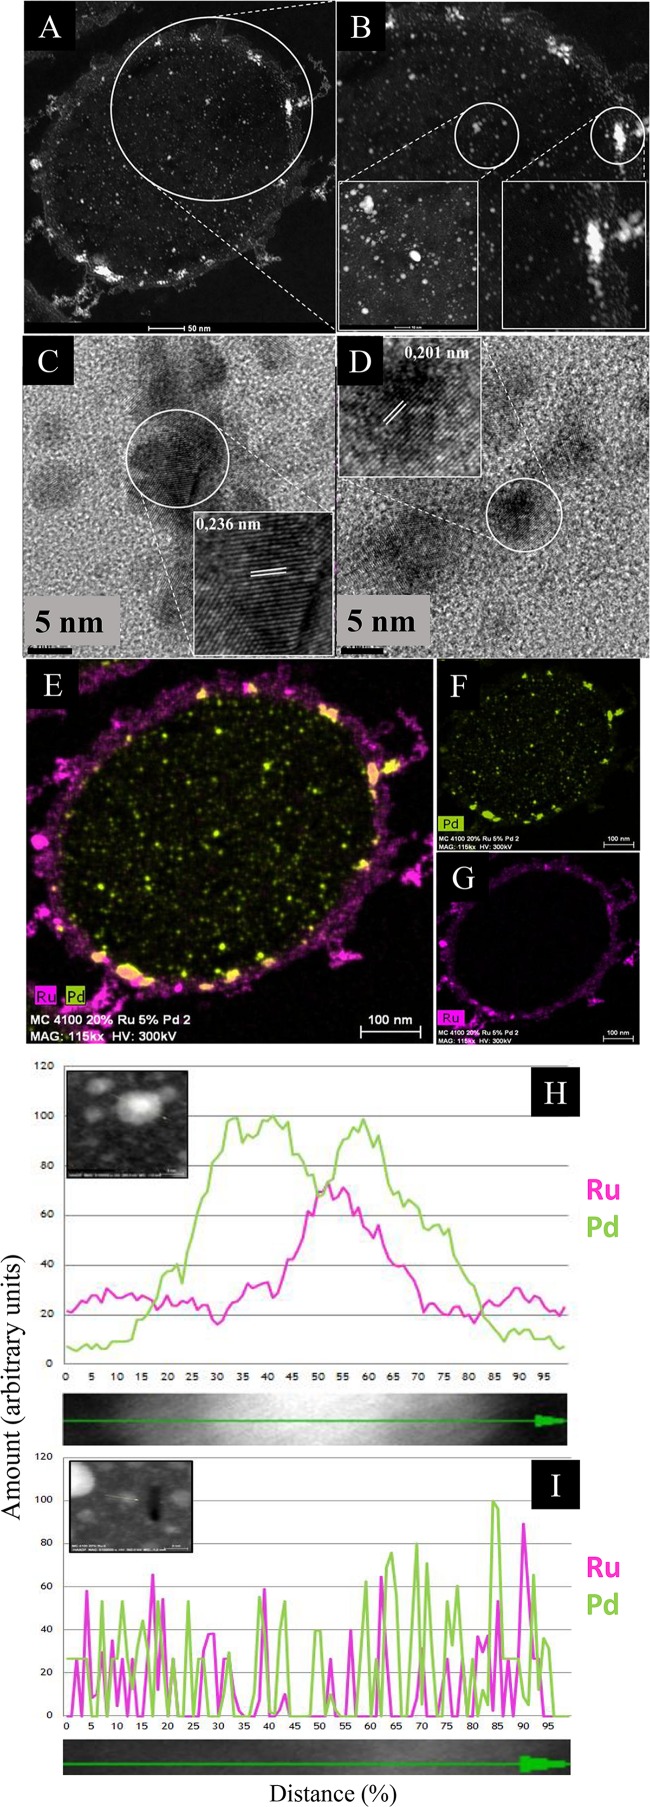
HAADF/STEM micrographs of cell sections showing Pd/Ru NPs (5 wt% Pd/20 wt% Ru). (A) A higher magnification panel (B) shows NPs located in the cell surface layers (B, inset right) and in the bulk region (B, inset left). Lattice spacing of example NPs in cell wall layers and intracellularly are shown in, respectively (C,D). Elemental maps (by EDX) of cells show co-localization of Pd and Ru (E) and individually Pd (F) and Ru (G). Elemental maps (by EDX) of a single nanoparticle showing a core/shell structure (H) and random distribution (I) of Pd and Ru.